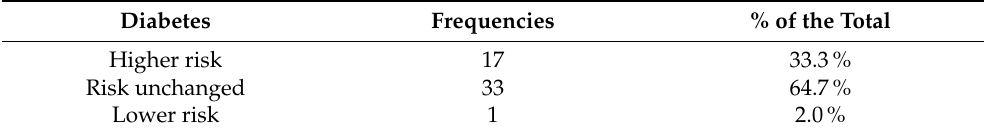
Table 1. Articles grouped by findings concerning diabetes as a risk factor for biological complications of dental implants.